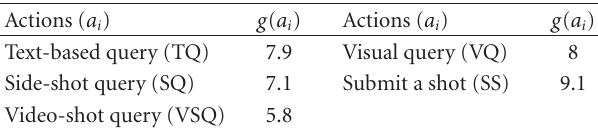
Table 1: Average assigned weights for each